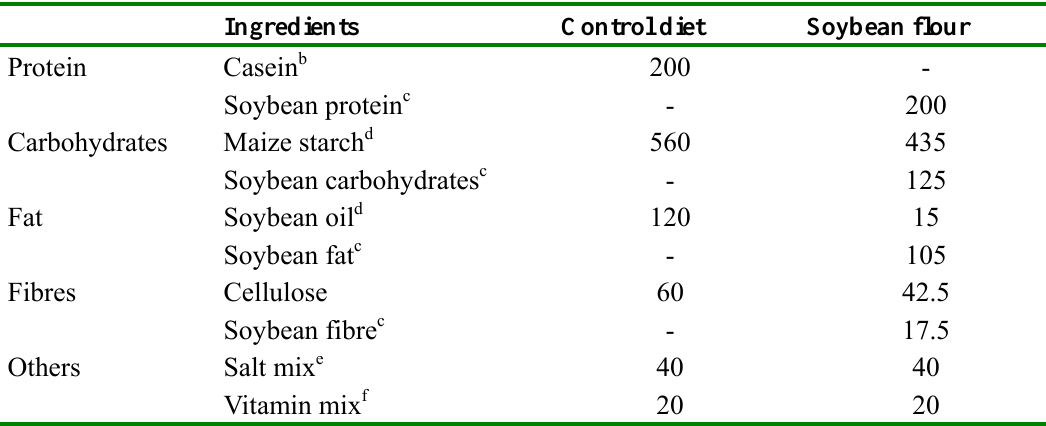
Table 1. Composition of the diets (g/kg) a